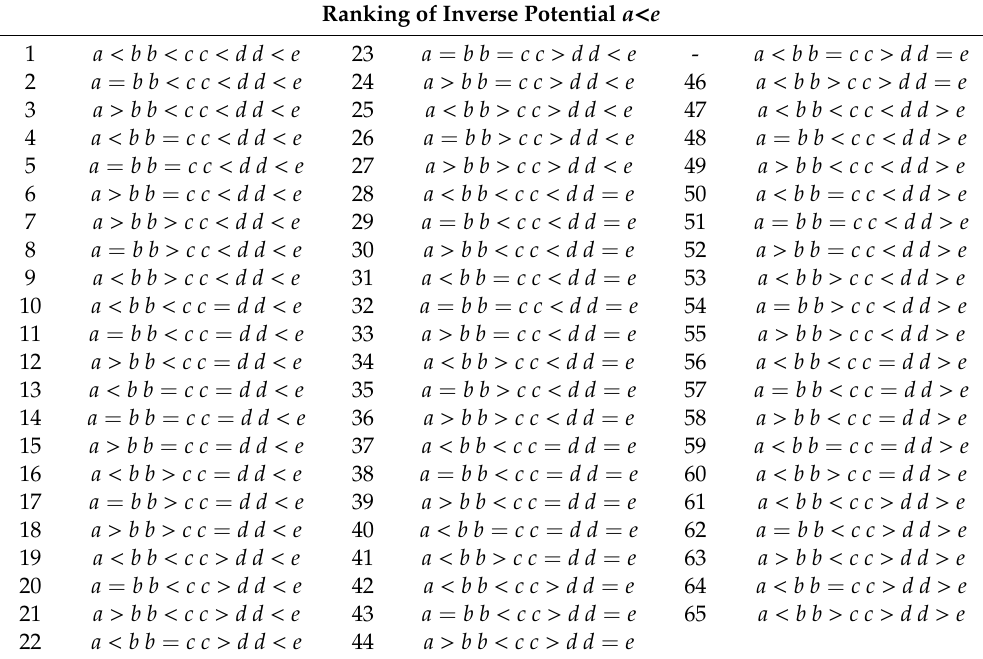
Table A2. The rank of five-element connection degree of inverse potential.